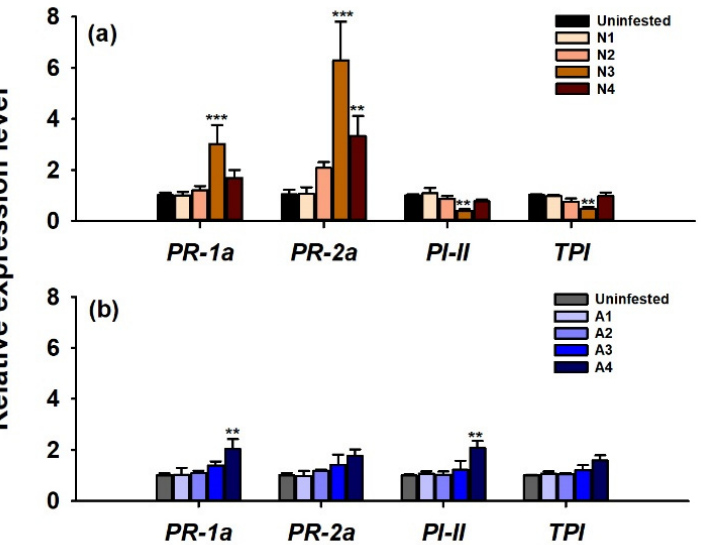
Figure 3. Relative expression of SA and JA pathway defense genes on systemic leaves of tobacco plants infested with B. tabaci MEAM1 nymphs ( a ) and adults ( b ). Asterisks indicate significant differences ( p ≤ 0.05). Error bars represent standard error of the means. The asterisks above the bars indicate significant differences (** p < 0.05, *** p < 0.001).